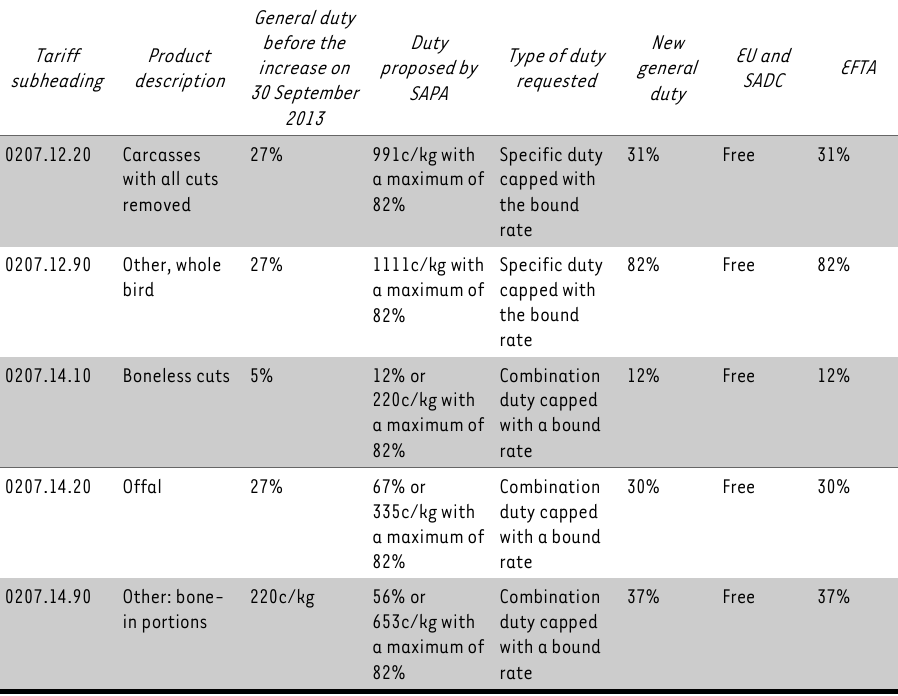
Increase in the rates of customs duty on frozen